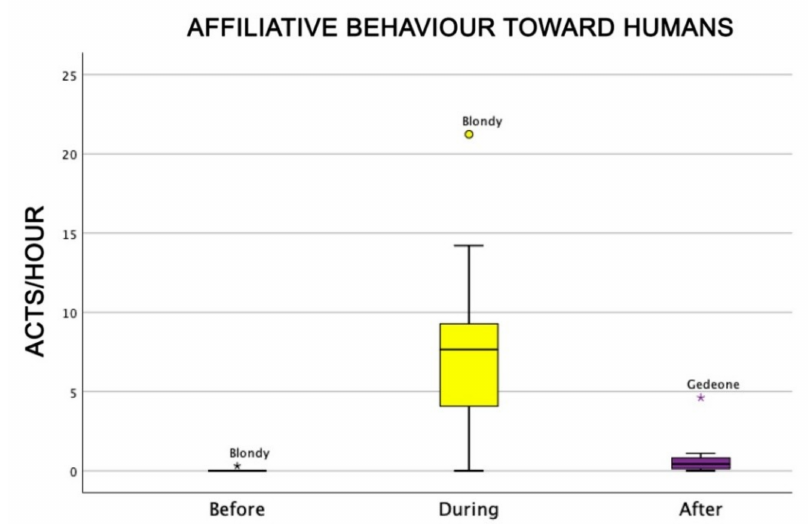
Figure 6. Behavioural patterns related to dogs’ a ffi liative behaviour towards humans before, during, and after AAI sessions. Non-parametric data are represented as medians (horizontal bar in the box) and the box indicates the interquartile range of 50% of the data. Whiskers extend to the smallest and largest values and exclude outliers (dot on